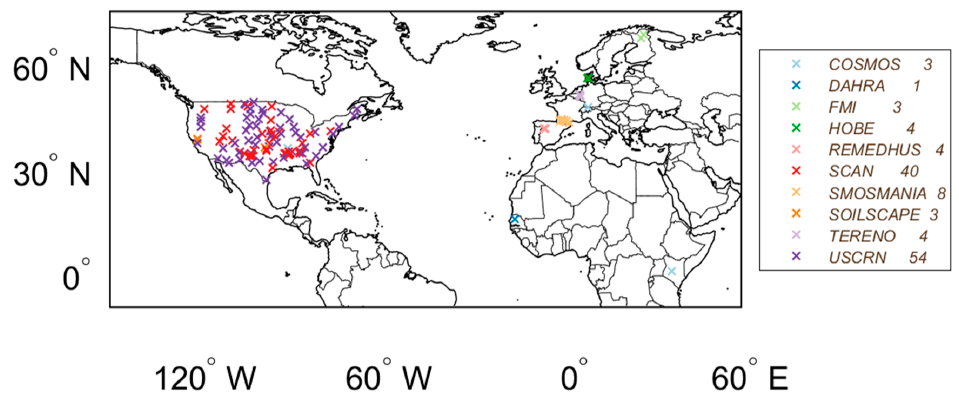
Figure 1. Locations of 124 ground stations from 10 networks used for the comparison with combined products.